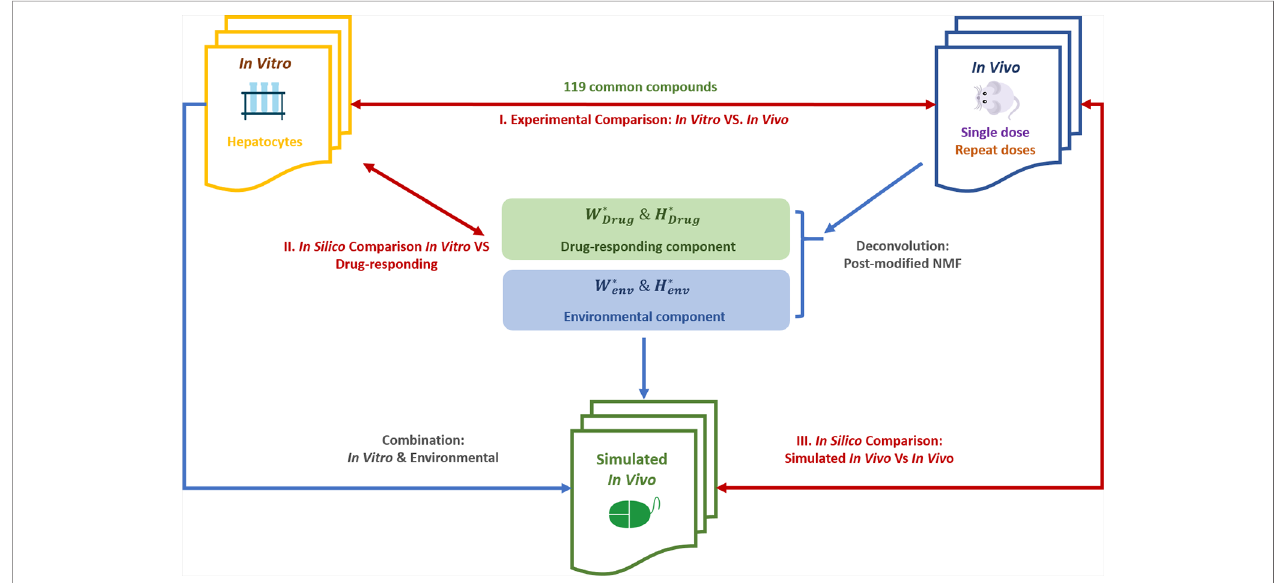
FIGURE 1 | The fl owchart of our study design. Post-modi fi ed NMF, post ‐ modi fi ed non ‐ negative matrix factorization; comparisons accomplished by using the pair ranking method (PRank score) and other indicators. W * drug , H * drug , W * env , H * env were deconvoluted from experimental in vivo